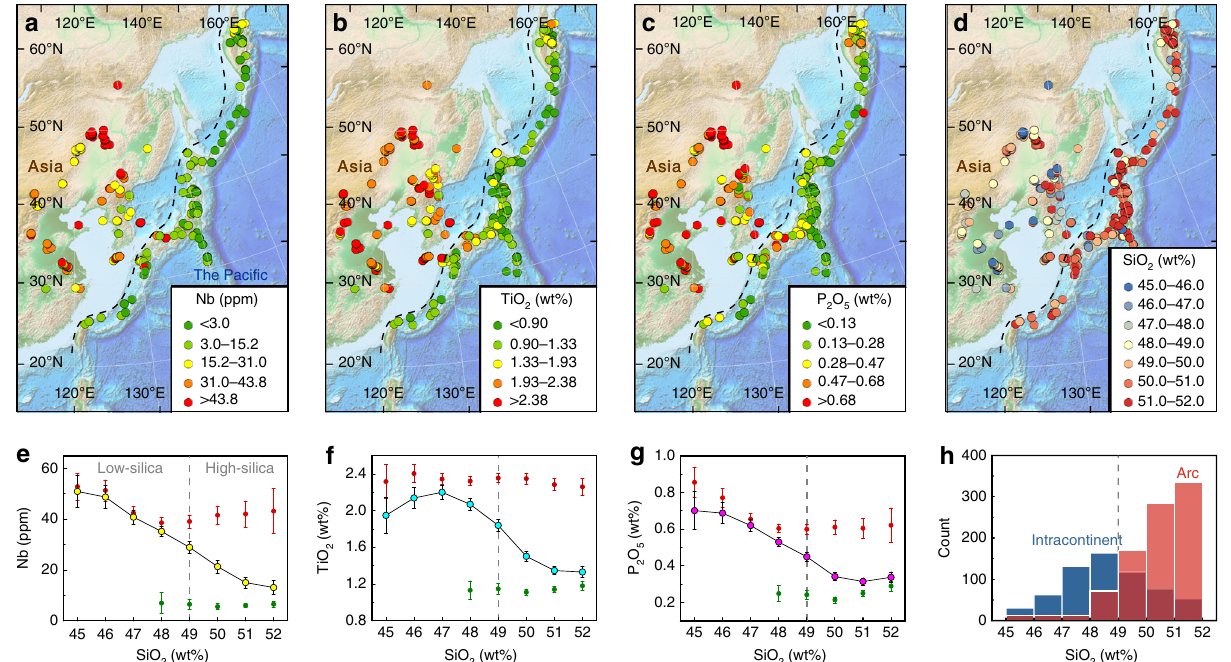
Fig. 2 Fractionation of Nb, Ti, and P-SiO 2 of ma fi c rocks from East Asia. a – d Locations and concentrations of Nb (ppm), TiO 2 (wt%), P 2 O 5 (wt%), and SiO 2 (wt%), respectively, of ma fi c rock samples (0 – 5 Ma ages) from East Asia. The black dashed lines divide the rock samples into arc (east) and continental (west) groups. Background relief maps are downloaded from NOAA website (https://www.ngdc.noaa.gov/) 61 . e – g Nb-SiO 2 , TiO 2 -SiO 2 , and P 2 O 5 -SiO 2 compositional trends, respectively, of ma fi c rocks within the map area. The circles with yellow, cyan, and magenta in fi lls denote the average Nb, TiO 2 , and P 2 O 5 concentrations, respectively, of all ma fi c rocks within the map area. Error bars denote two standard errors of the means (s.e.m.). The gray vertical- dashed line shows a proposed subdivision between low-silica (45 – 49 wt% SiO 2 ) and high-silica (49 – 52 wt% SiO 2 ) ma fi c rocks. h Histograms showing the frequency of arc (red) and intracontinental (blue) ma fi c rocks